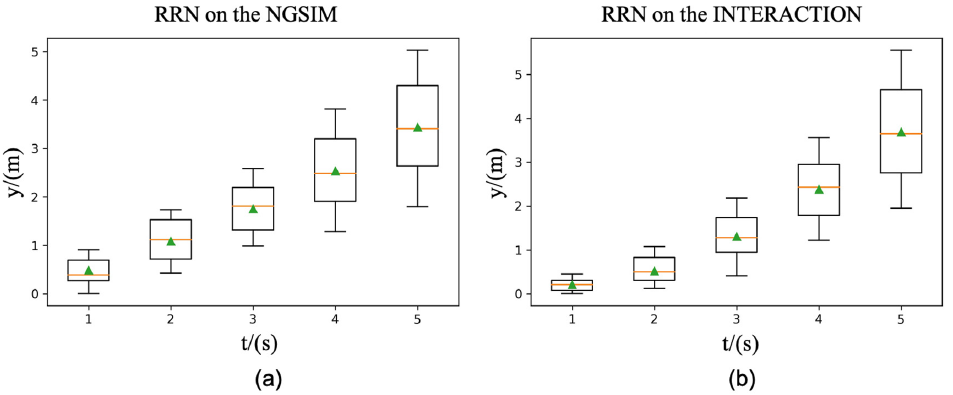
Figure 3. Error distributions of trajectory prediction on the NGSIM and INTERACTION, respectively. The x-axis denotes 5 evaluation points as 1 s, 2 s, 3 s, 4 s, and 5 s; ( a ) Box-plot of RMSE based on RRN on the NGSIM dataset; ( b ) Box-plot of RMSE based on RRN on the INTERACTION